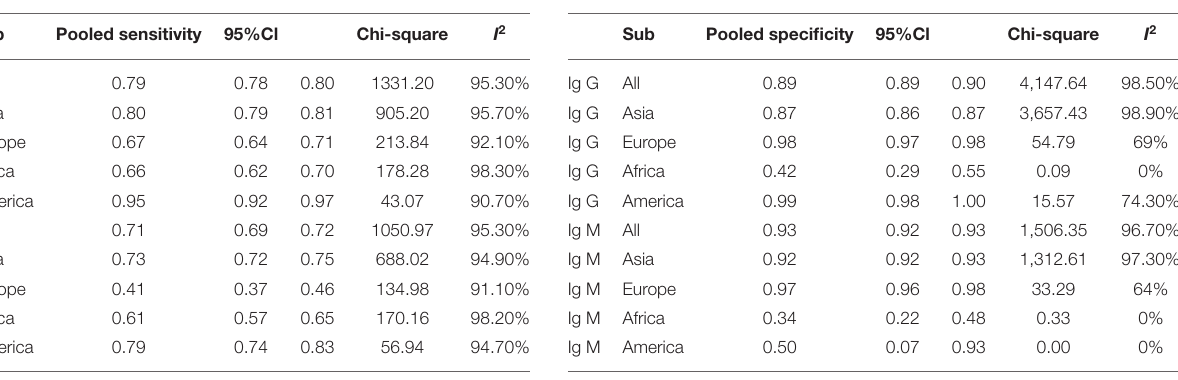
TABLE 2 | Subgroup analysis of specificities for IgG and IgM to predicting COVID-19